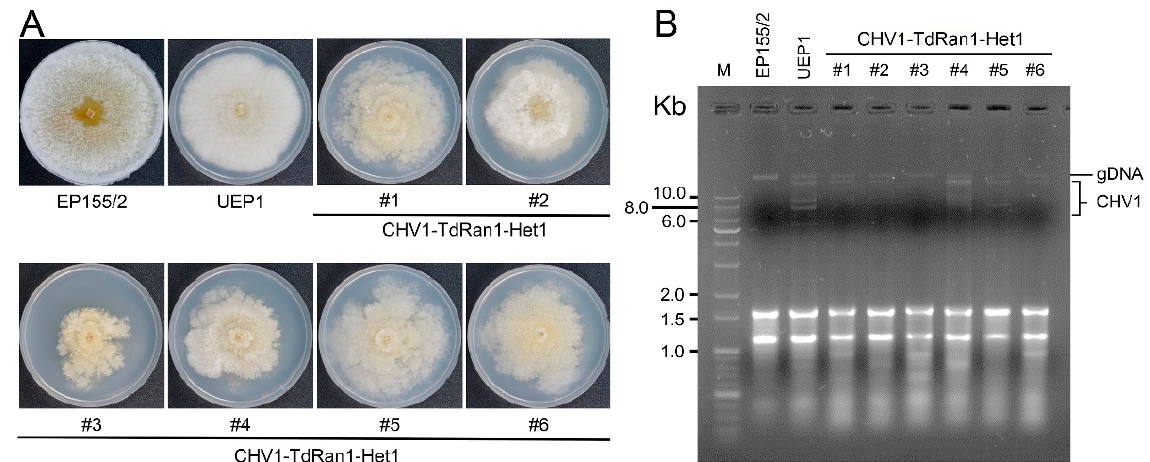
Figure 7. Effect of CHV1 infection to heterokaryons. ( A ) Colony morphology of CHV1-infected heterokaryotic CpRan1 - null mutant. Strains included are virus-free (EP155/2), a virus-infected isogenic strain (UEP1), and six representative CHV1-infected heterokaryotic progenies (CHV1-TdRan1-Het1 #1-#6). Strains are marked at the bottom of the plate. ( B ) Gel electrophoresis of dsRNA isolated from 0.1 g of lyophilized